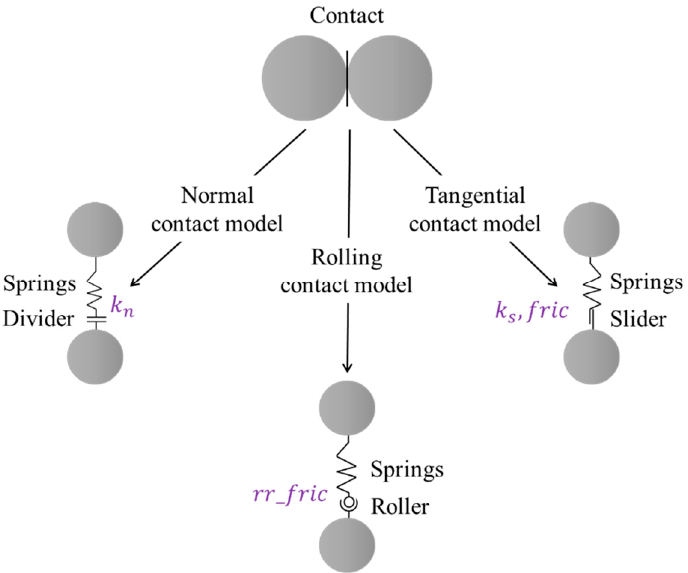
Figure 9. Illustration of micromechanical components of the rolling stiffness contact model used for DEM simulations.